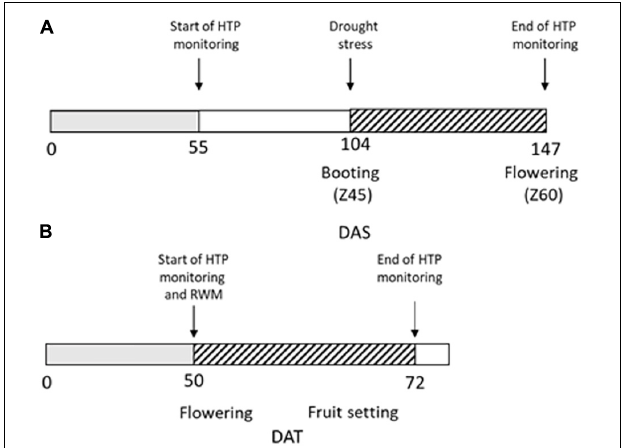
FIGURE 1 | Experimental design of the high throughput phenotyping (HTP) experiment. (A) Durum wheat plants were regularly irrigated up to 104 DAS (days after sowing, gray box); drought stress (dashed box) was then imposed for 43 days from 104 to 147 DAS. RGB images for HTP were acquired from 55 DAS to 147 DAS; (B) Tomato plants were regularly irrigated up to 50 days from transplant (gray box) when reduced water management (RWM) was performed and biostimulants were applied three times in the 22 days indicated with the dashed